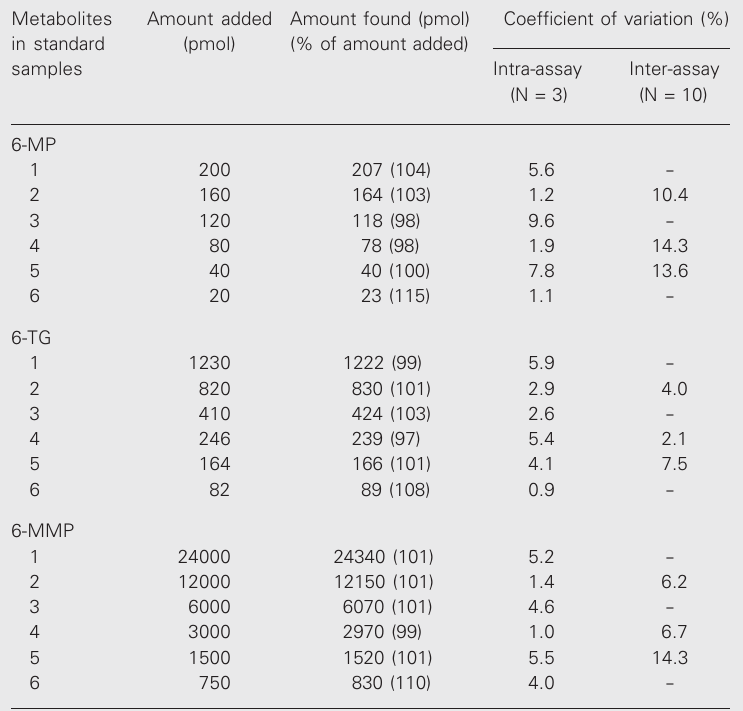
The erythrocytes (8 x 10 8 ), obtained from healthy volunteers, were suspended in 200 µl Hanks solution and spiked with the indicated amount of the metabolites. Extraction, hydrolysis and HPLC analysis were performed as described in Methods. The amount found was back-calculated from the calibration curve. For abbreviations, see Figure